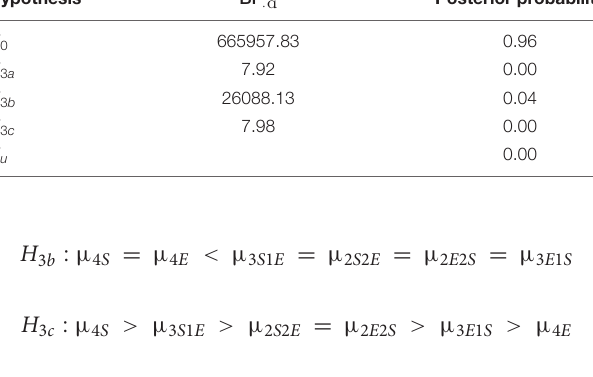
Own calculations using wbmonitor 2019.